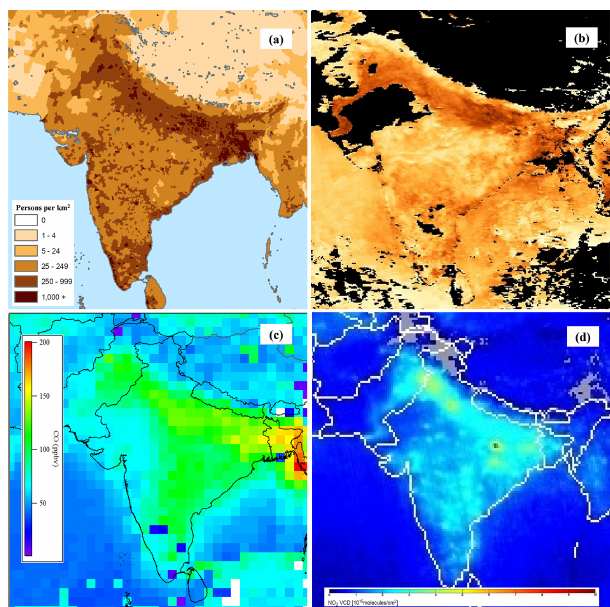
Figure 8. Spatial distribution of population density in 2000 (a) , AOT (b) , surface CO (c) , and NO 2 VCD (d) in May 2013 over the Indian subcontinent and the TP.